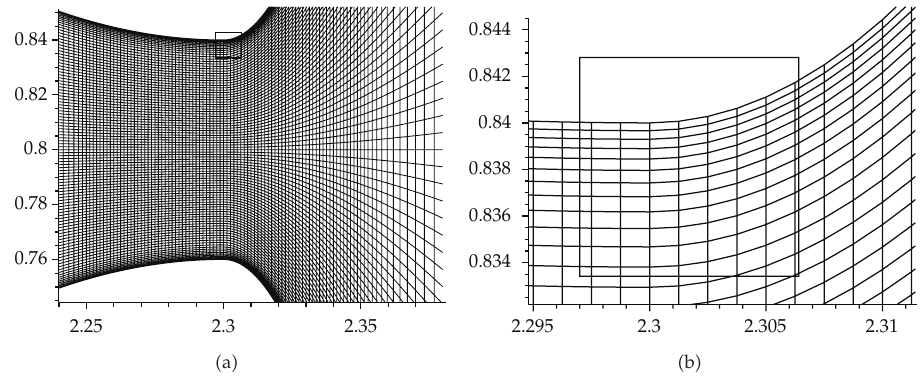
Figure 3: Grid of quadrilateral cells in the narrowest part of domain D 1 at the middle position of the gap . (cid:4) 5 · 10 − 4 (cid:2) 0 . 01mm (cid:3) width g (cid:4) 0 . 08 (cid:2) 1 . 6mm (cid:3) . Detail: Δ y min